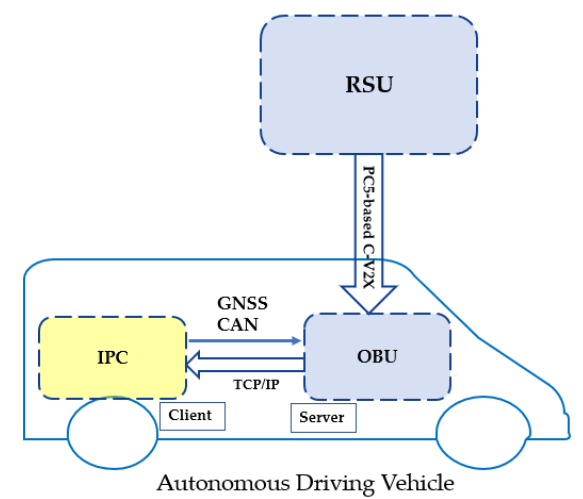
Figure 7. PC5-based C-V2X VRUCW.